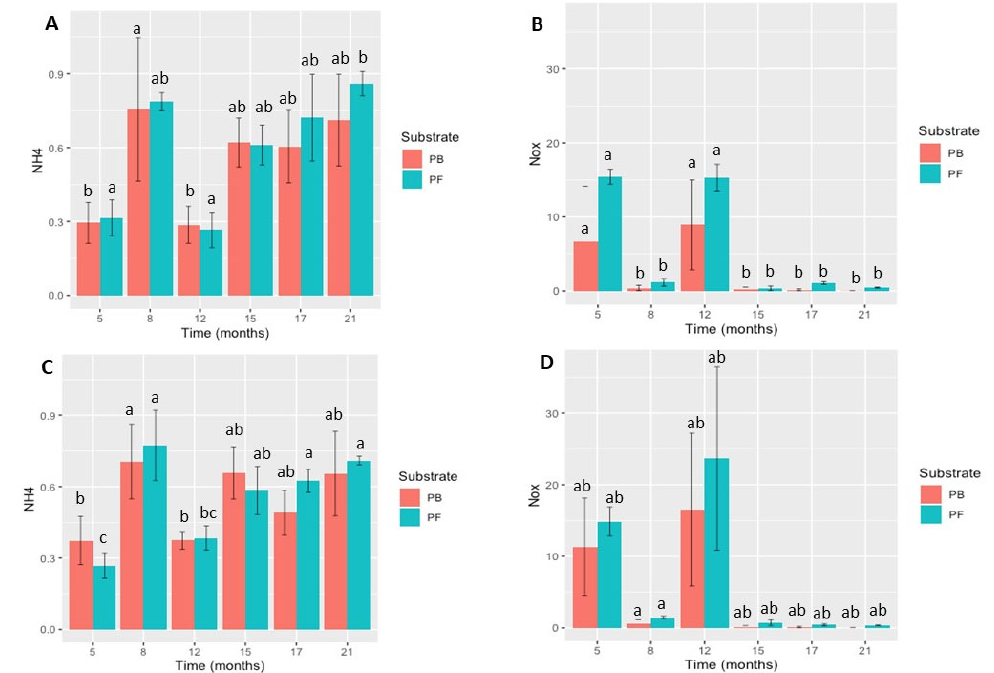
Figure 2. Survival of Phytophthora cryptogea and P. cactorum in peat-based (PB) and peat-free (PF) substrates: ( A ) ammonia (NH4) concentration (mg/L) of peat-based and peat-free substrates inoculated with P. cryptogea ; ( B ) nitrogen (NO-x) concentration (mg/L) of peat-based and peat-free substrates inoculated with P. cryptogea; ( C ) ammonia (NH4) concentration (mg/L) of peat-based and peat-free substrates inoculated with P. cactorum ; ( D ) nitrogen (NO-x) concentration (mg/L) of peat-based and peat-free substrates inoculated with P. cactorum . Vertical bars indicate standard deviation (SD); n = 5 for each sampling date. Different letters above bars indicate significant differences between sampling dates after inoculation ( p <